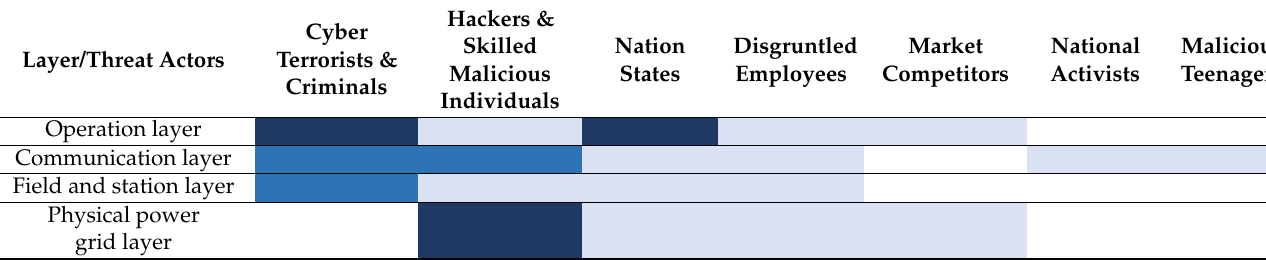
Table 15. Cyber threat profile across